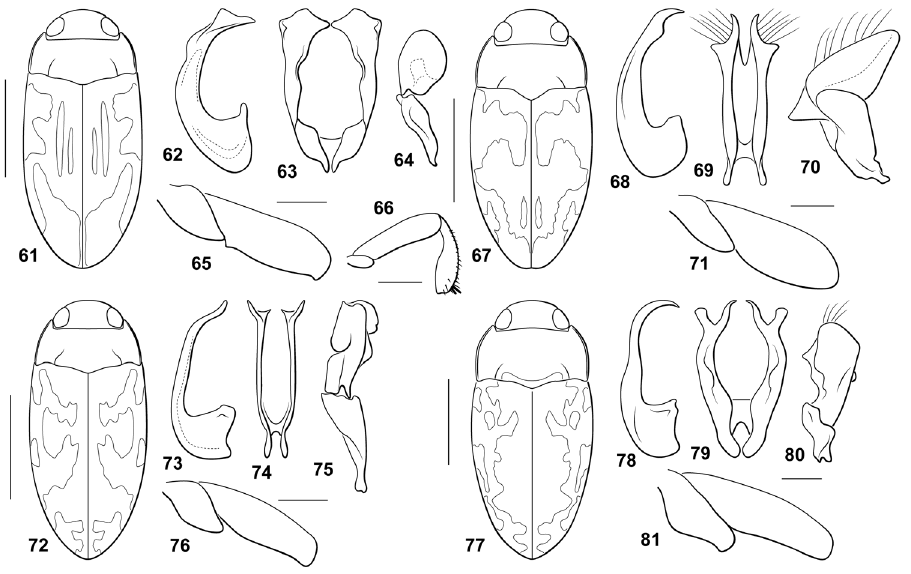
Figures 61–81. Bidessodes species. 61–66 B. jucundus 61 dorsal habitus, scale = 1 mm 62 male geni- talia 62 median lobe, right lateral aspect 63 median lobe, ventral aspect 64 right lateral lobe, right lateral aspect 65 left metatrochanter and metafemur, anterior aspect, scale = 0.25 mm 66 left mesotro- chanter, mesofemur and mesotibia, anterior aspect, scale = 0.25 mm 67–71 B. knischi 67 dorsal habitus, scale = 1 mm 68 male genitalia 68 median lobe, right lateral aspect 69 median lobe, ventral aspect 70 right lateral lobe, right lateral aspect 71 left metatrochanter and metafemur, anterior aspect, scale = 0.25 mm 72–76 B. nessimiani 72 dorsal habitus, scale = 1 mm 73 male genitalia 73 median lobe, right lateral aspect 74 median lobe, ventral aspect 75 right lateral lobe, right lateral aspect 76 left metatro- chanter and metafemur, anterior aspect, scale = 0.25 mm 77–81 B. obscuripennis 77 dorsal habitus, scale = 1 mm 78 male genitalia 78 median lobe, right lateral aspect 79 median lobe, ventral aspect 80 right lateral lobe, right lateral aspect 81 left metatrochanter and metafemur, anterior aspect, scale = 0.25 mm. Bidessodes jucundus Young, 1986